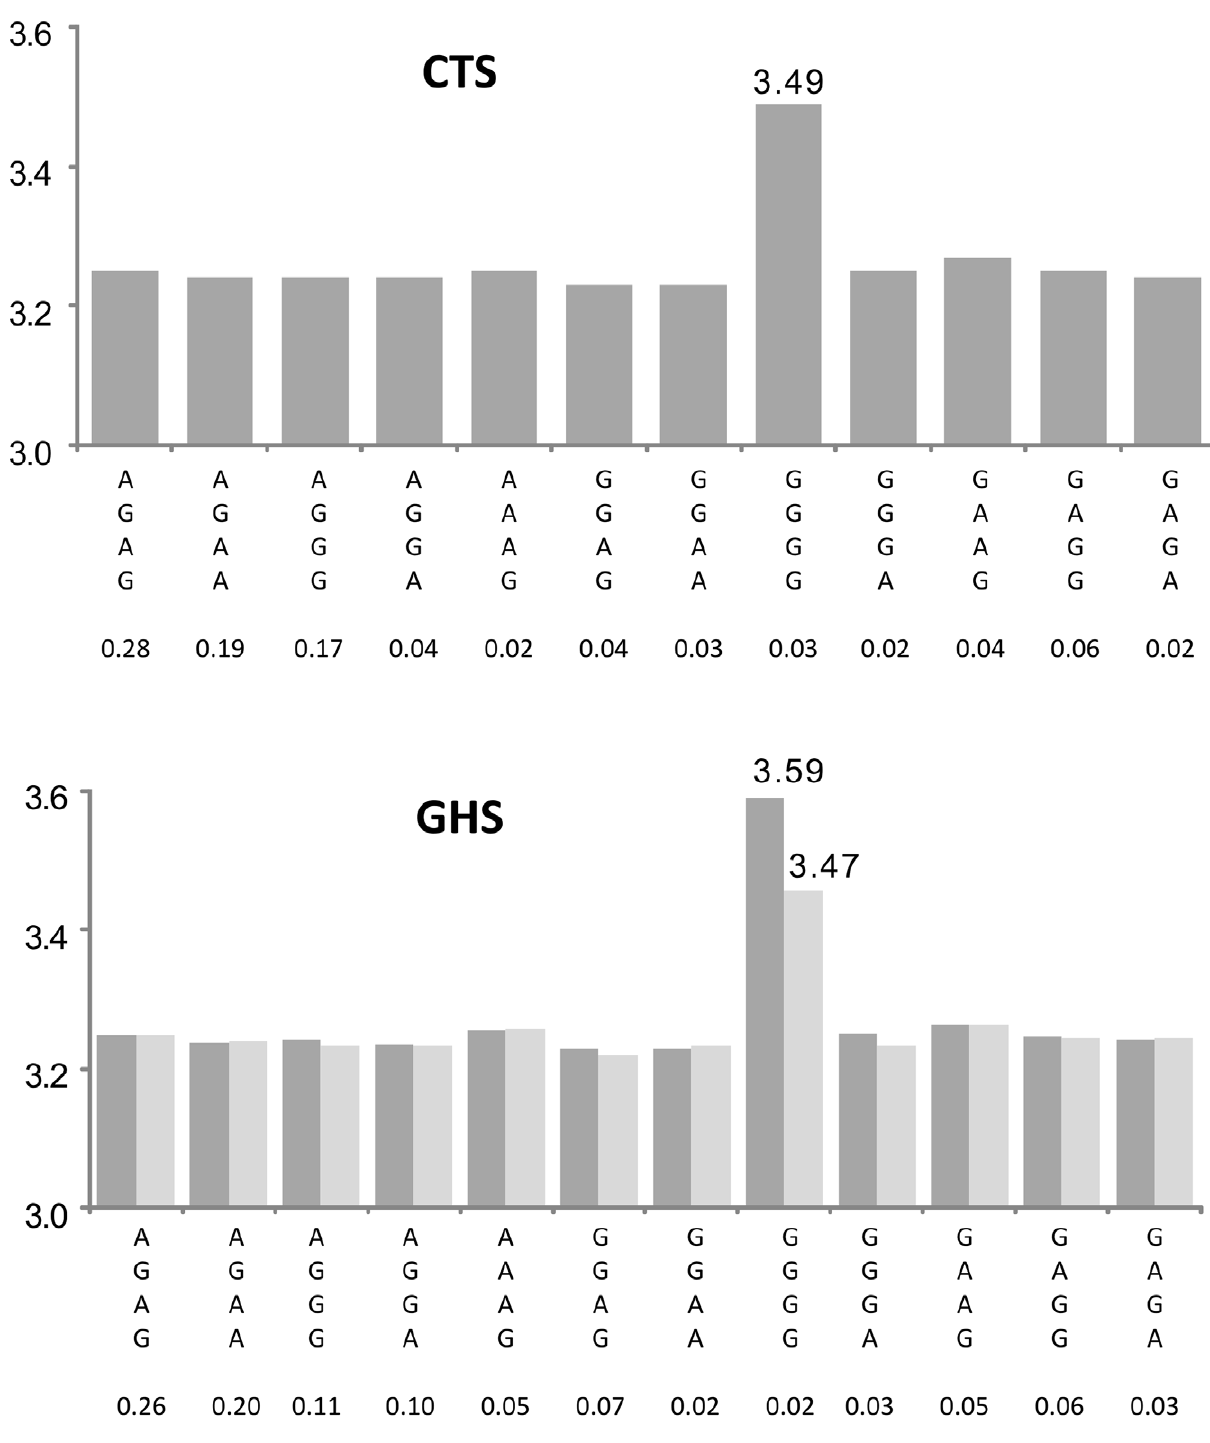
Figure 6. Association between ILMN_1757379 ( OPN1SW ) expression and the haplotypes derived from rs1109552, rs4731507, rs4731513, and rs339088. The top panel shows the results in the discovery cohort CTS and the bottom panel in the replication cohort GHS. Each bar corresponds to the expected mean of gene expression associated with one dose of the corresponding haplotype under the assumption of additive haplotype effects. According to this model, the expression level of an individual is the sum of the levels of his (her) two haplotypes. Haplotype frequencies are indicated under each haplotype label. In CTS, the rs4731507 and rs339088 were substituted by their perfect proxies (r 2 =1) rs4283986 and rs339085, respectively. The original haplotypic association (dark grey bars) was due to a unique rare haplotype derived from 4 common htSNPs. This rare haplotype, GGGG, was associated with a strong increase in OPN1SW expression ( b = + 0.240, p=8.12 10 2 26 and b = + 0.341, p , 10 2 307 in CTS and GHS, respectively). After adjusting in GHS for the best imputed cis eSNP rs142976957 (light grey bars), the effect of this rare haplotype was still highly significant ( b = + 0.208, p=4.78 10 2 135 ).